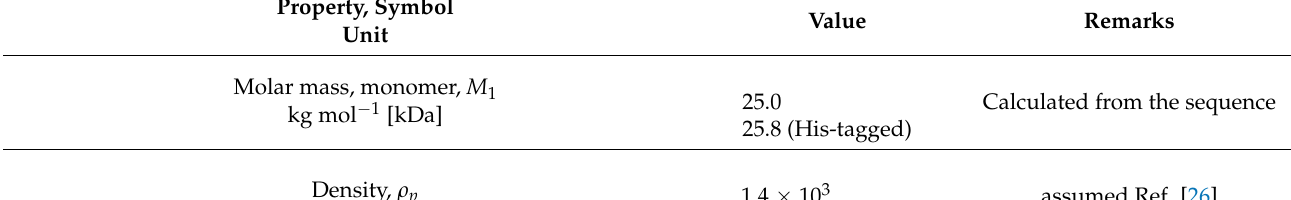
Table 1. Physicochemical parameters of SARS-CoV-2 S1R molecule monomer.